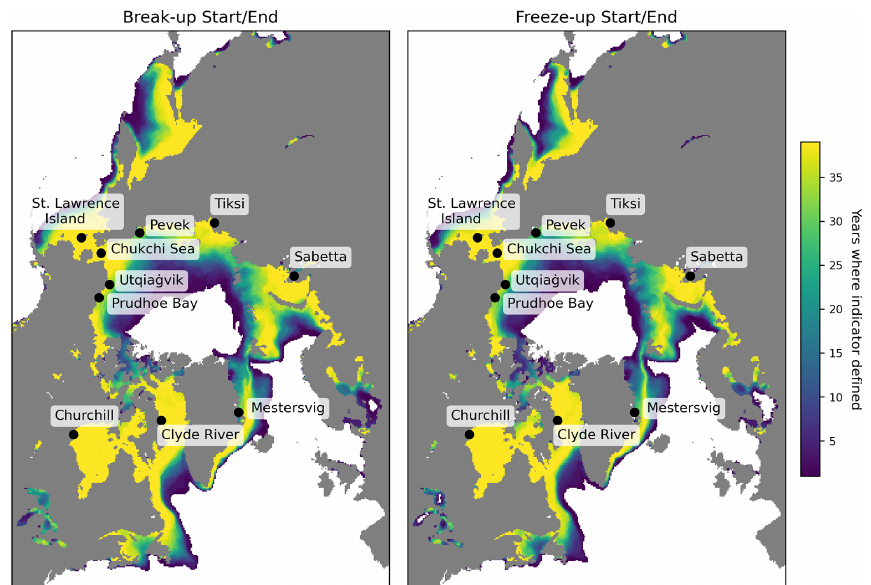
Figure 4. Number of years in the 1979–2018 study period in which the breakup and freeze-up indicators were defined. Note that end dates for breakup and freeze-up exist only for years in which there are start dates for breakup and freeze-up. The start and end dates of the overall data record (1 January 1979–31 December 2018) can result in differences of 1 year in the counts when freeze-up occurs around 1